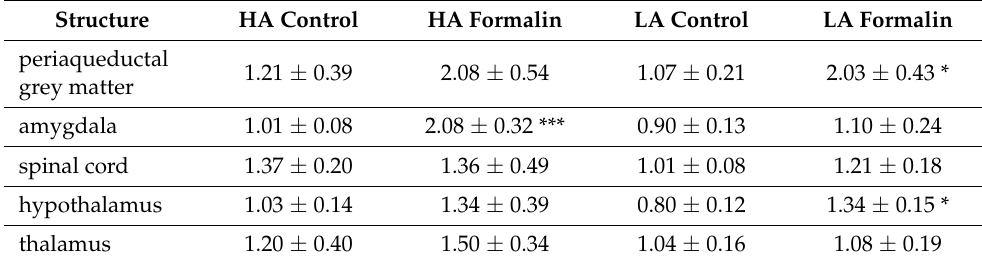
Table 2. Cannabinoid receptor 2 (Cnr2) mRNA levels in HA and LA mice in the interphase of the formalin test. Mice were injected with 5% formalin (in PBS) into the dorsal aspect of the hind paw ( n = 4–6). Samples were harvested 15 min post-formalin. Results were analysed within each line with two-way ANOVA followed by Bonferroni’s post-hoc test. Statistical significance was depicted as follows: * p ≤ 0.05; *** p ≤ 0.001 (vs. control).